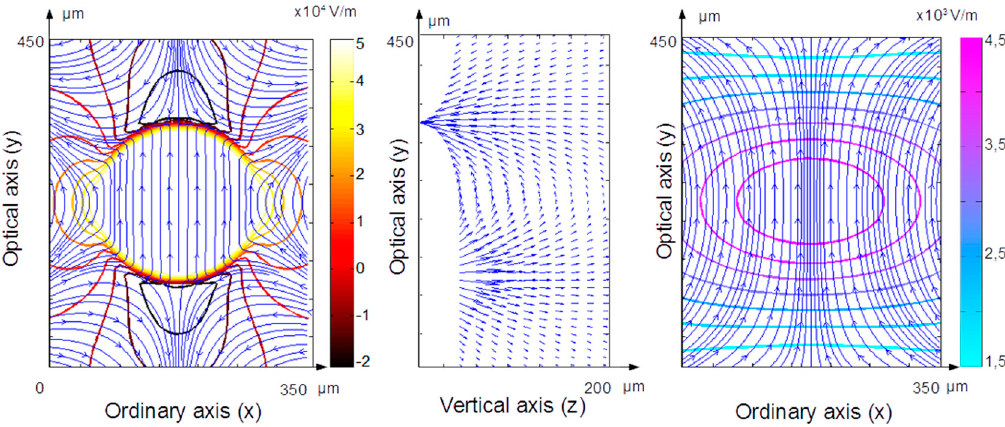
Figure 3. Simulation of the electric field above the photorefractive crystal, underlying the field lines. Left : E -field calculated on the transversal x-y plane located 1 µm above the crystal. Right : E -field on the x-y plane 200 µm above the crystal. It is interesting to notice that close to the crystal surface the E -field decreases from about 50 kV/m to less than 4 kV/m within a 200 µm range along the optical axis. Center : E -field distribution estimated in the y-z vertical plane corresponding to the center of the beam at x = 175 µm.